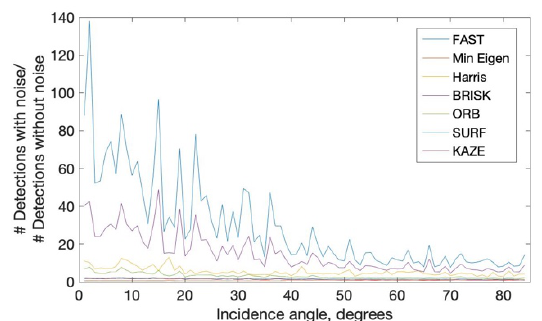
Figure 5 . Increase in the number of false feature detections when salt and pepper noise is applied to 2.5% of the frame.